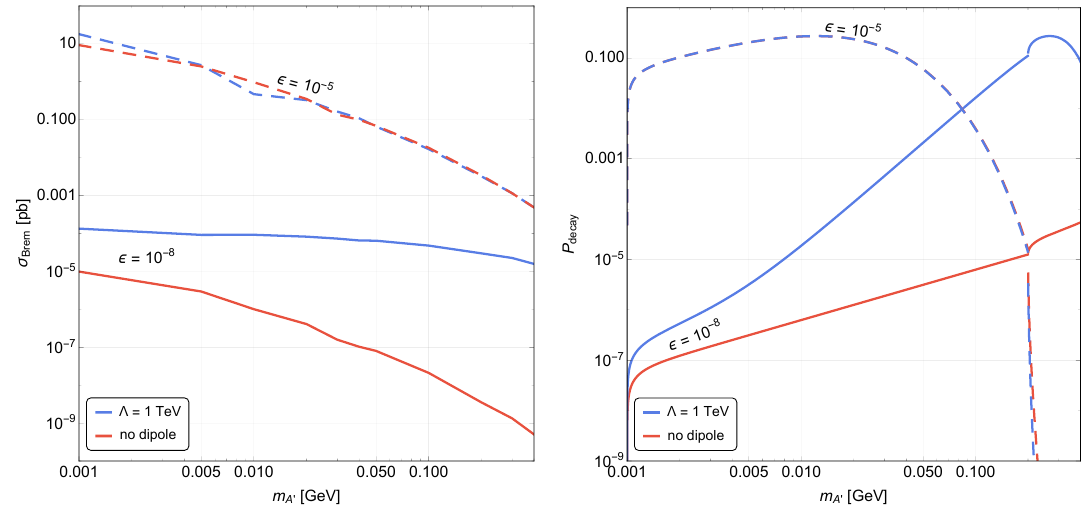
Figure 6 . Left panel: Bremsstrahlung cross section as a function of the dark dipole mass for (cid:15) = 10 − 5 (dashed lines) and (cid:15) = 10 − 8 (solid lines) in the absence of the dark dipole (red lines) and with a dark dipole scale Λ = 1 TeV (blue lines). Right panel: decay probability into leptons computed according to eq. (3.6). Same color code as in the left panel. We fix d